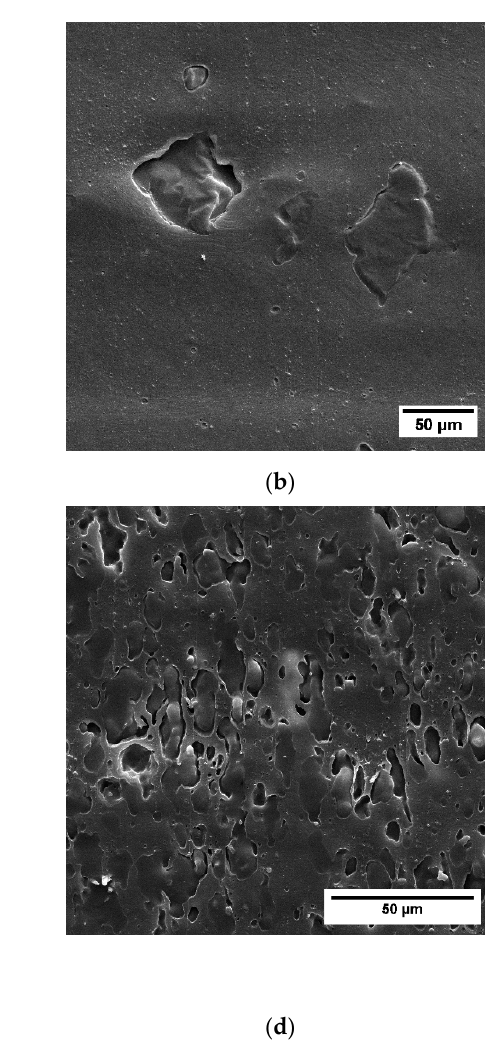
Figure 6. Cryo-sliced surfaces of the samples without soybean oil (SBO). ( a ) Without EMAGMA and Tert-butylperoxy 2-ethylhexyl carbonate (TBEC), ( b ) with 1 phr TBEC, ( c ) with 5 pph EMAGMA, and ( d ) with 5 pph EMAGMA and 1 phr TBEC.